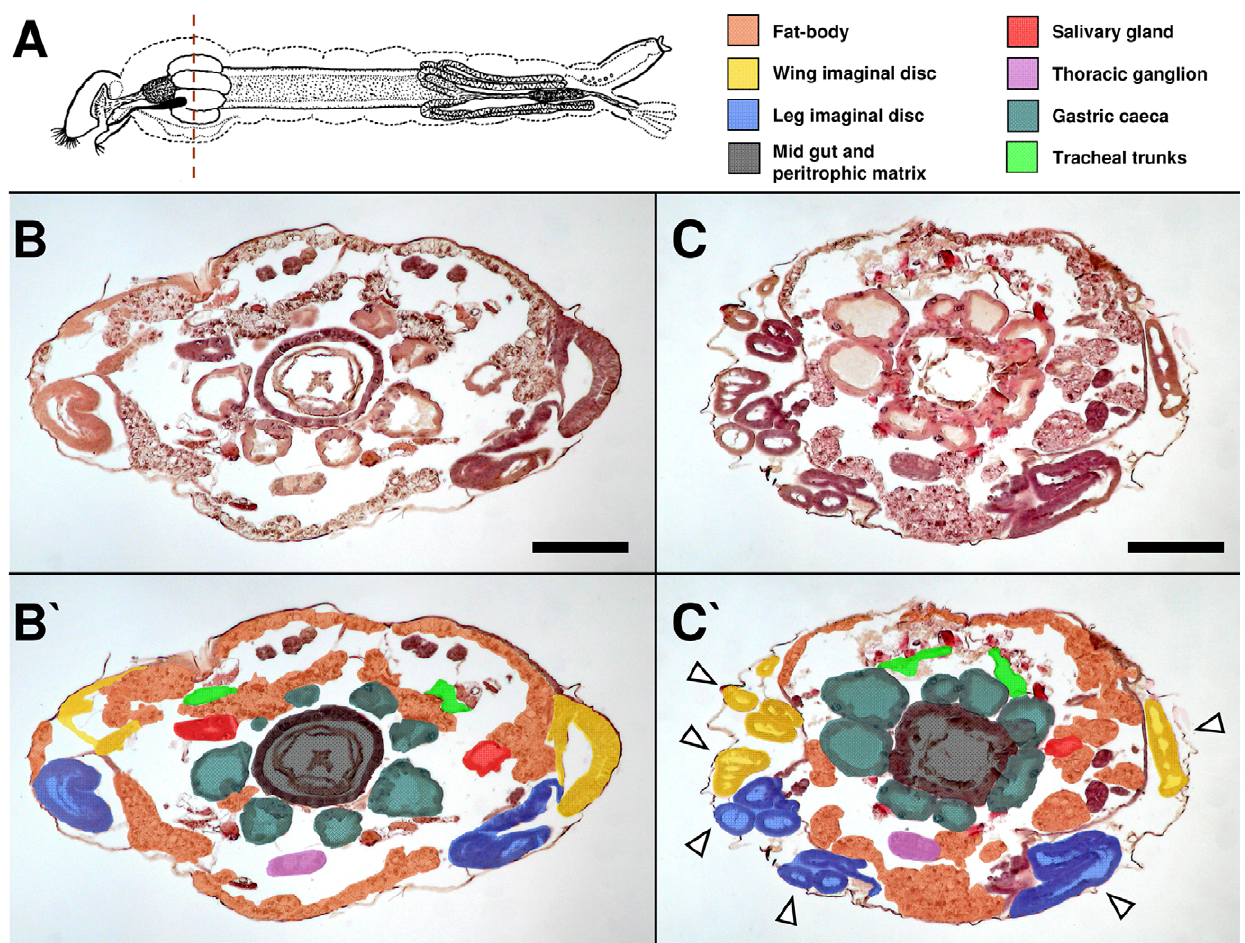
Figure 5. Novaluron induces histological alterations on Ae.aegypti larvae. Bright field microscopy. ( A ) Larva scheme with histological section region evaluated (mesothorax, dashed line) and color caption for identified organs and tissues. HE staining of live L4l larvae from control ( B , B 9 ) and novaluron EI 99 ( C , C 9 ) are shown. In ( B 9 ) and ( C 9 ) sections shown in the corresponding panels were colored to better identify structures. In ( C 9 ) arrowheads indicate disorganized imaginal discs (see Figure S2 for further details). In ( A ), larva scheme adapted from Christophers [3]. Bar=200 m m.